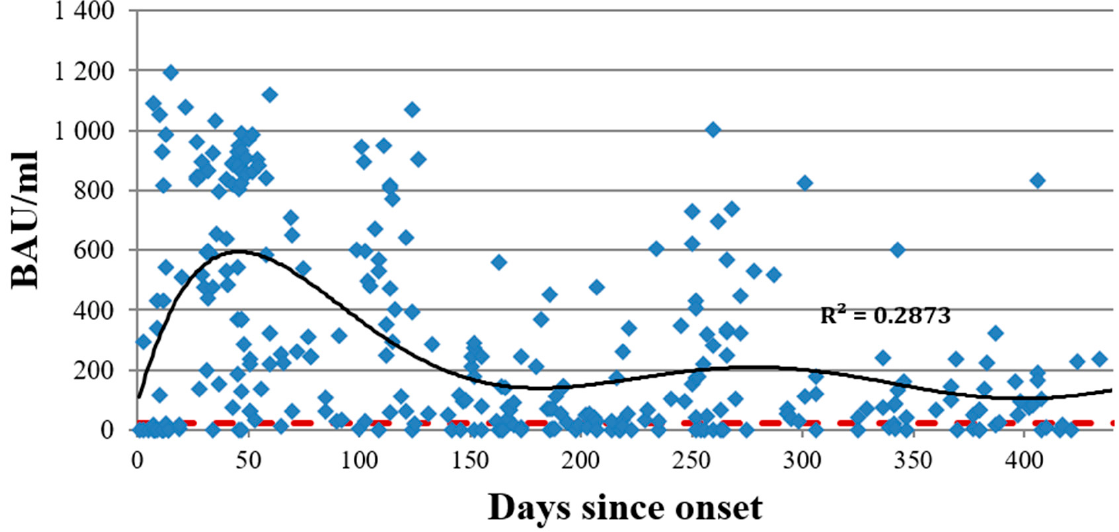
Figure 5. Total anti-S protein (RBD) antibody dynamics (ELISA) as a function of time since COVID-19 onset for 312 individual patients. The range was from 1 to 438 days. IgG concentration is presented in BAU/mL. The red dotted line represents the cut-off value for this specific ELISA kit (22.6 BAU/mL). The black line is the trend, with an R 2 of 0.28.